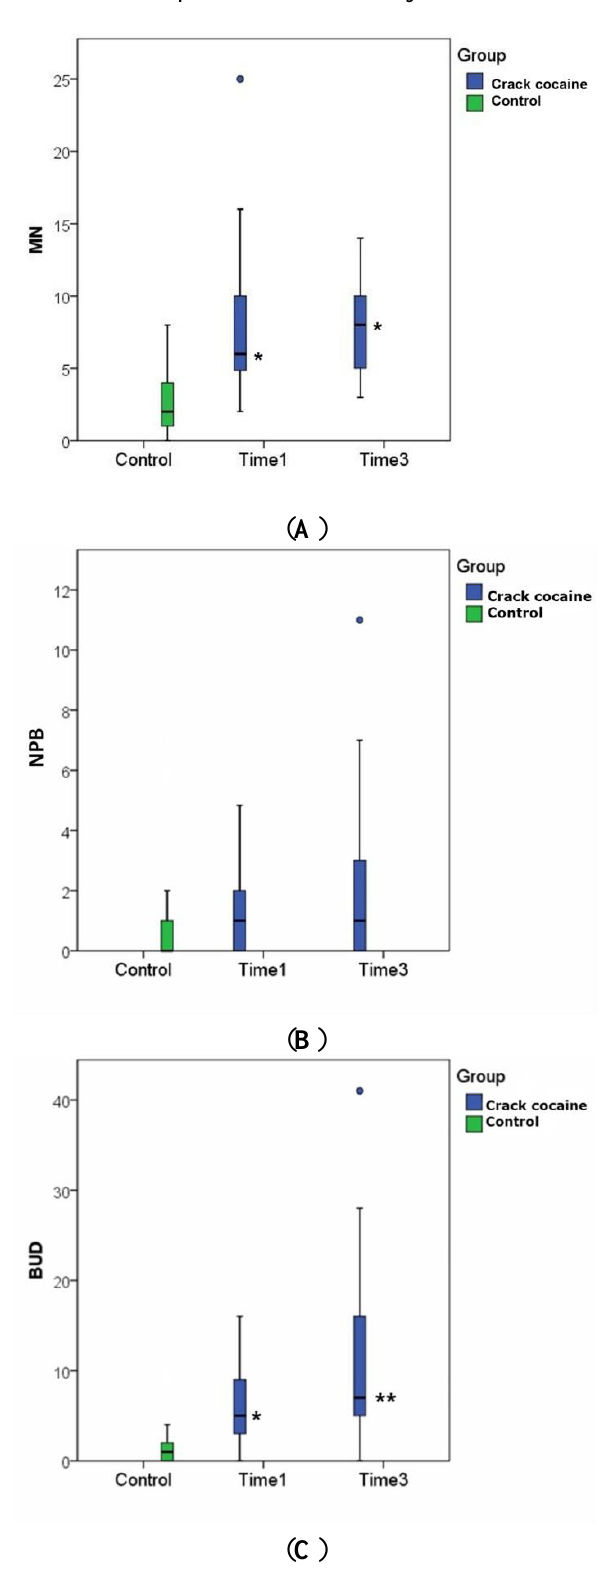
Figure 1. Distribution of MN ( A ), NPB ( B ) and NBUD ( C ) values at Time Points 1 and 3 and comparison with the control group; ● outliers: values that lie more than one and a half times the length of the box from the end of the box; statistically significant differences: * versus the control group; ** versus Time Point 1; Time 1: beginning of withdrawal; Time 3: at the end of the treatment period (21 to 30 days after